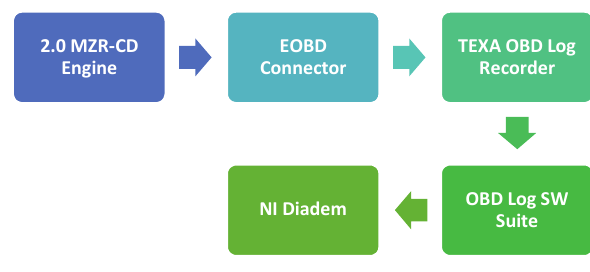
Fig. 3. Diagram of data collection and investigation